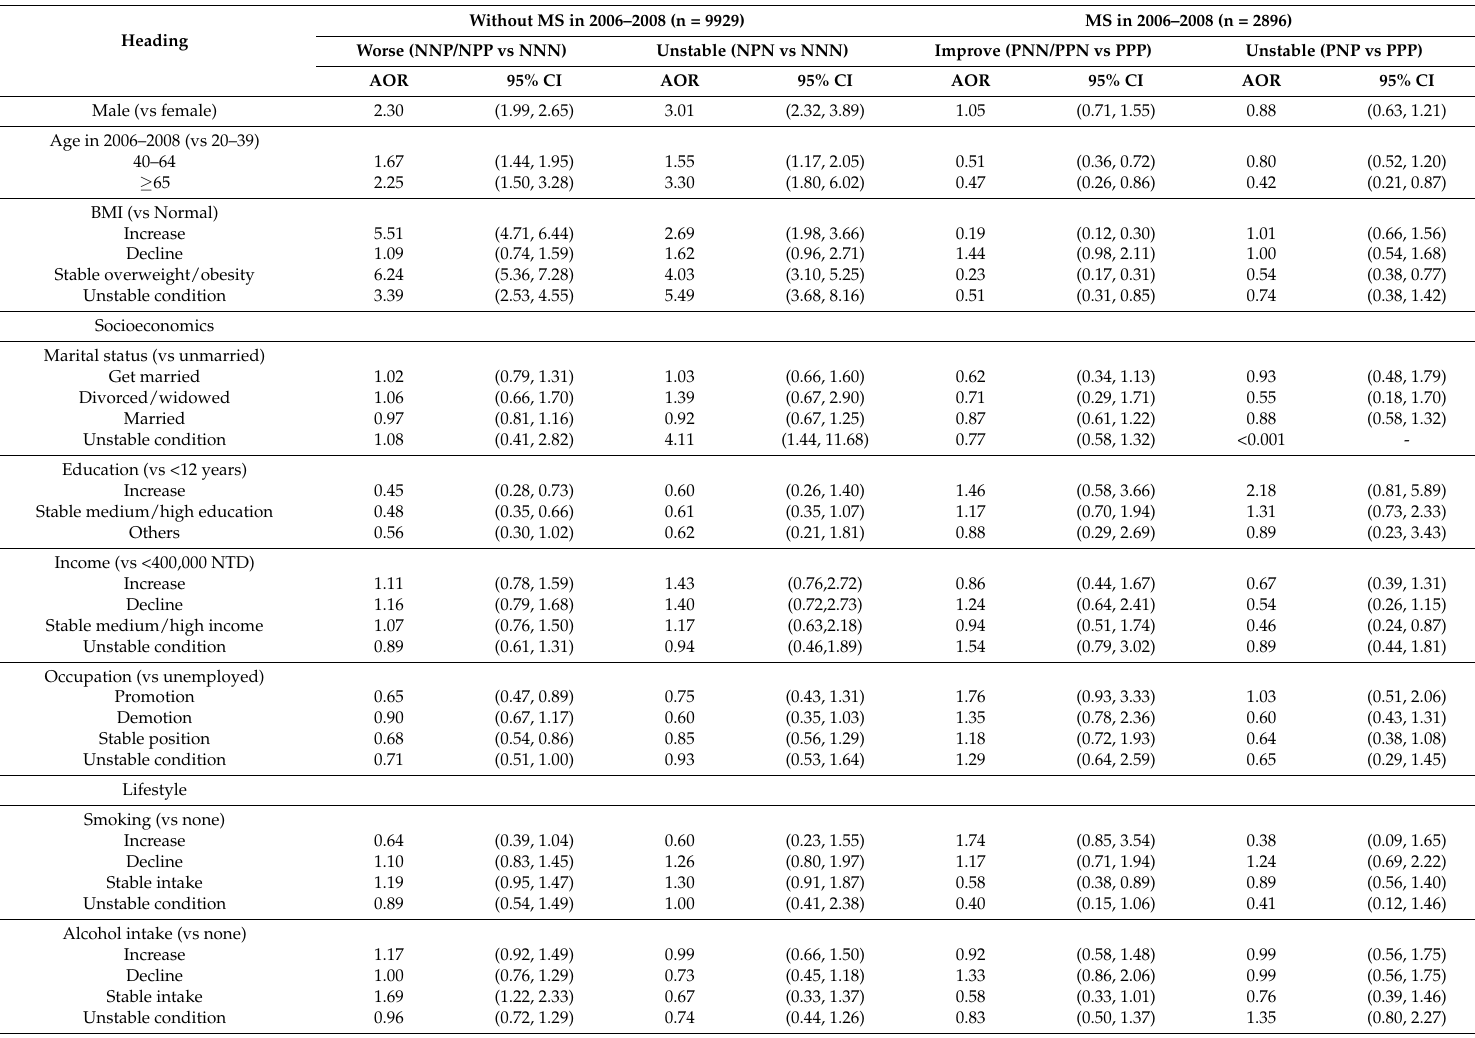
Table 3. Odds ratios (95% confidence intervals) of socioeconomic patterns and lifestyle conditions for metabolic syndrome over the three study